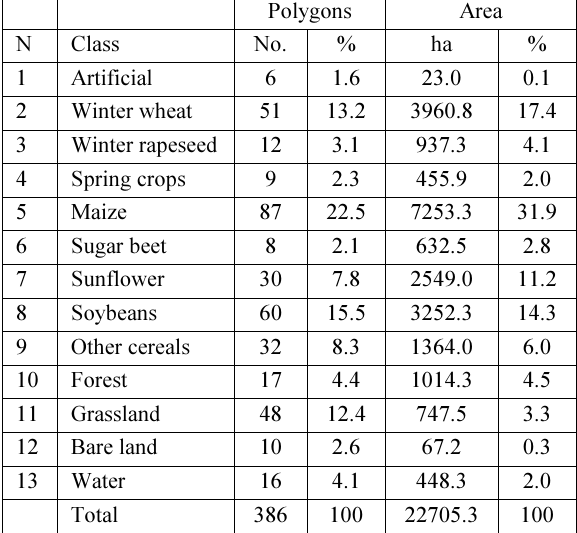
Table 1. Number of polygons and total area of crops and land cover types collected during the ground survey